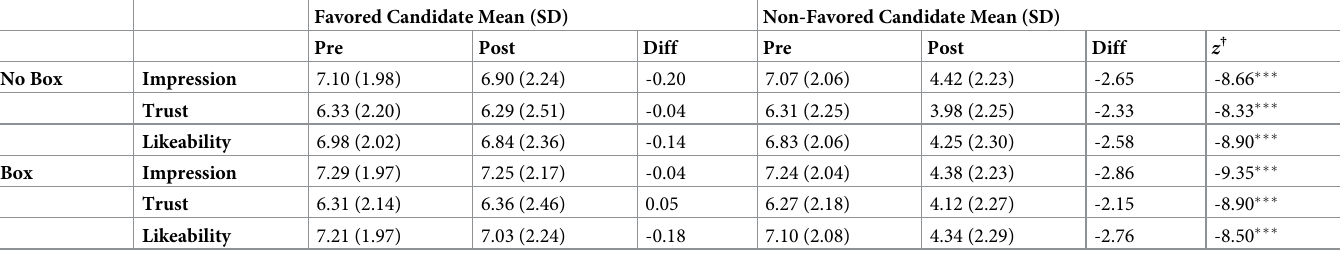
Table 2. Experiment 1: Pre- and post-search opinion ratings of favored and non-favored